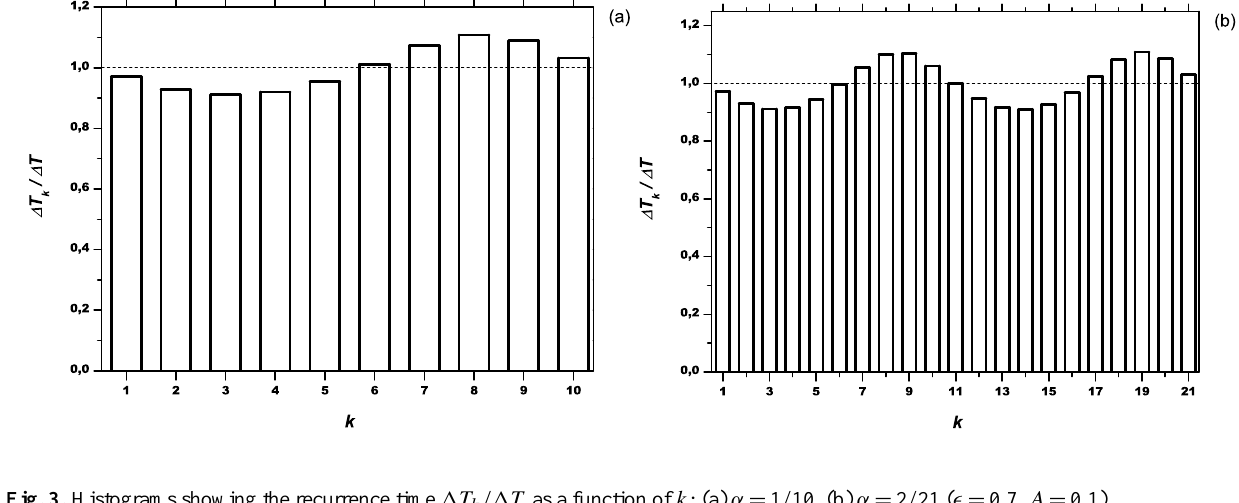
Fig. 3. Histograms showing the recurrence time 1T k /1T as a function of k : (a) α = 1 / 10, (b) α = 2 / 21 ( (cid:15) = 0 . 7, A = 0 .